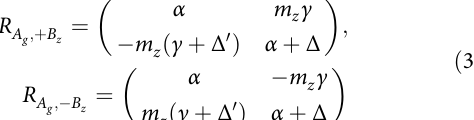
magnetic fi eld direction is fl ipped from B z to − B z , thus fl ipping the direction of the induced magnetization, the signs of the off- diagonal elements switch, resulting in the opposite rotation of the polar plot, exactly as we observed in Fig. 4b and Supplementary Fig. 7. Figure 4c shows the angle of maximum intensity of the polar plot in 4a as the magnetic fi eld is swept through the phase transition, where Regions 1 – 6 from Fig. 3 are marked with vertical dashed lines. Although Fig. 3 and magneto-tunneling results indicate that parts of the phase transition occur between Regions 2 and 4, there is no observable change in the maximum intensity of the polar plot in those fi eld ranges. In Region 5, however, it increases to ≈ 10° for B = 1.7 T and 1.8 T, and then fi nally to ≈ 35° for 1.8 T and above. The lack of rotation of the polar plot between 0.7 T and 0.8 T reveals that not enough magnetization is induced in this fi eld range to introduce the off- diagonal Raman tensors in Eq. (2). different temperatures between T = 9 K and 26 K, as detailed in Fig. 4d. The intensity of P 2 is shown relative to the intensity of the = B 3 at ≈ 115 cm − 1 at B = 0 T for each combination peak A 5 g g temperature, as this peak appears to remain constant with temperature and magnetic fi eld (in the probed range). The spin- fl ip transition fi eld, or the amount of magnetic fi eld necessary to cause P 2 to disappear, decreases with increasing temperature. In addition, the distinct jumps from spin fl ips and fl at plateaus observed in the intensity of P 2 smooth out for higher T . Further temperature dependence is analyzed in Supplementary Fig. 8.